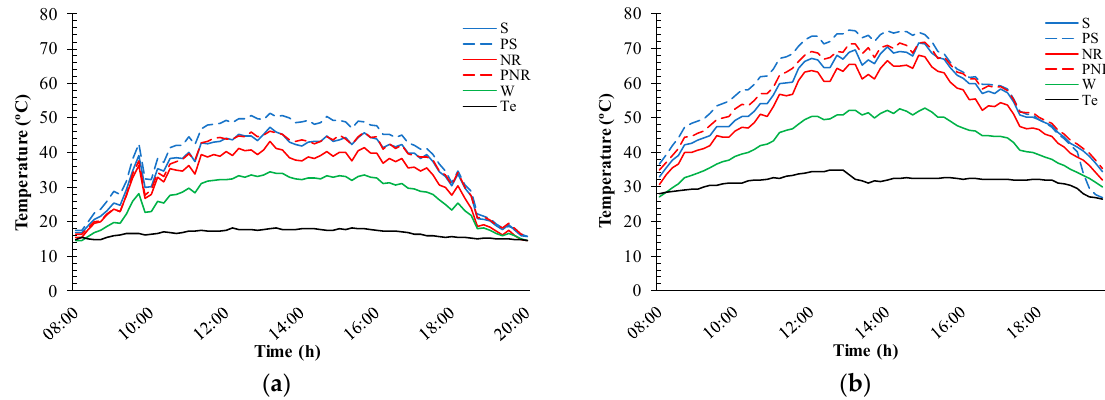
Figure 9. Surface temperature in: ( a ) Day of lower temperatures (M12); ( b ) Day of high temperatures (M13). A statistical analysis of a representative week of each period (mild and hot) is shown in Figures 10 and 11, respectively.